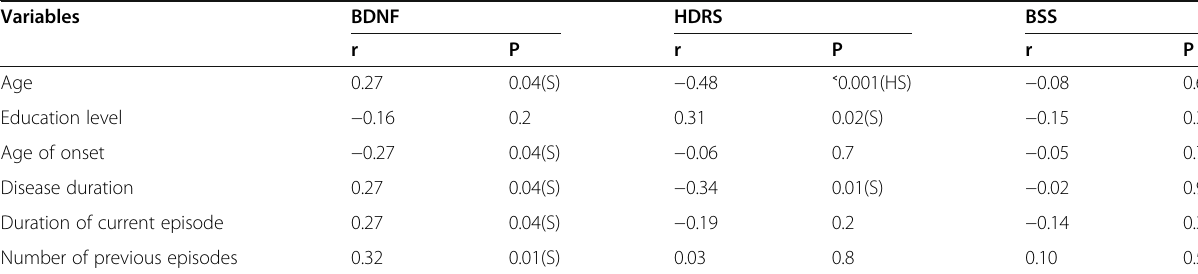
Table 4 Correlation between BDNF, HDRS, BSS, and other variables in the MDD group Variables BDNF HDRS BSS r P r P r P Age 0.27 0.04(S) − 0.48 ˂ 0.001(HS) − 0.08 0.6 Education level − 0.16 0.2 0.31 0.02(S) 0.3 Age of onset − 0.27 0.04(S) − 0.06 0.7 Disease duration 0.27 0.04(S) − 0.34 0.01(S) − 0.02 0.9 Duration of current episode 0.27 0.04(S) − 0.19 0.2 − 0.14 0.3 Number of previous episodes 0.32 0.01(S) 0.03